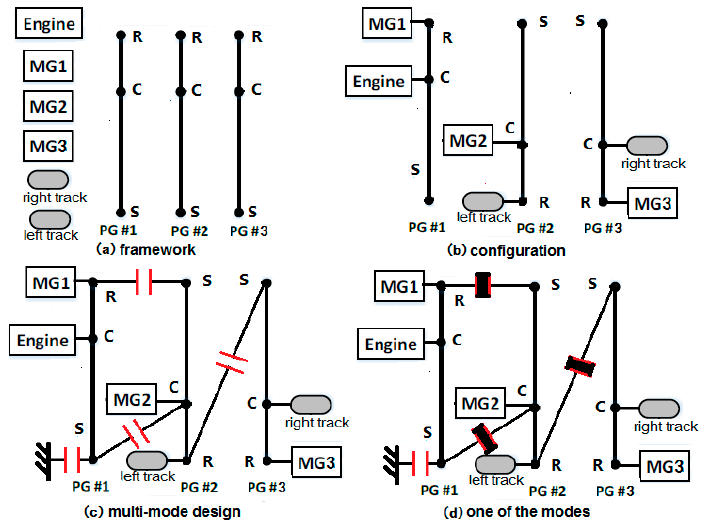
Figure 2. Configuration, design, and mode generation process.